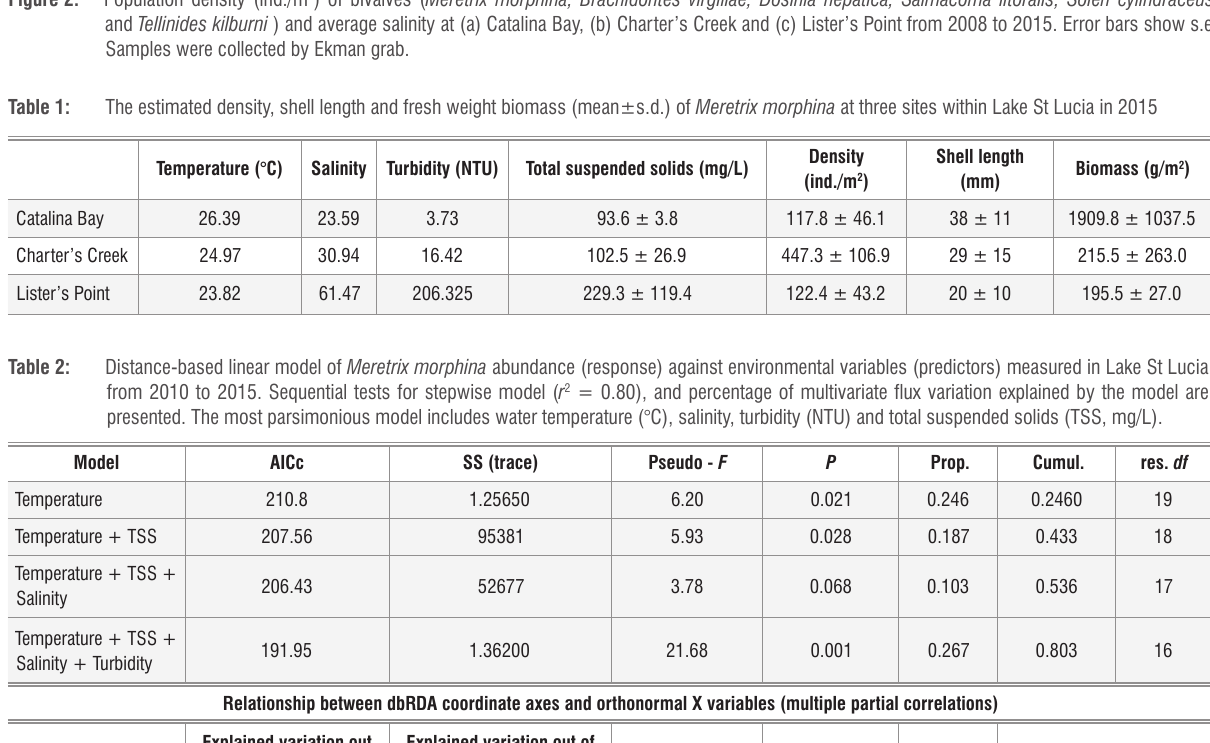
Temperature + TSS + Salinity + Turbidity Relationship between dbRDA coordinate axes and orthonormal X variables (multiple partial correlations) Explained variation out Explained variation out of Axis Temperature TSS of fitted model (%) total variation (%)